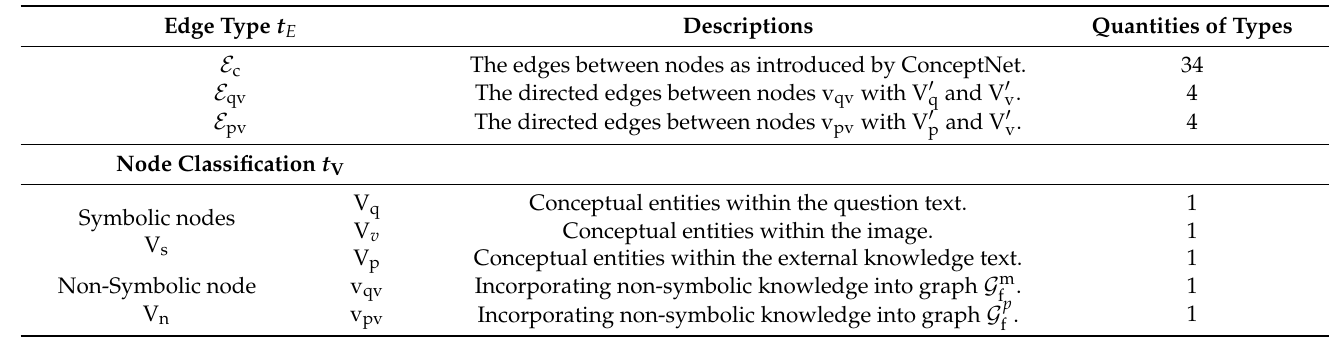
Table 2. Categories, descriptions, and quantities of nodes and edges type in MSG.